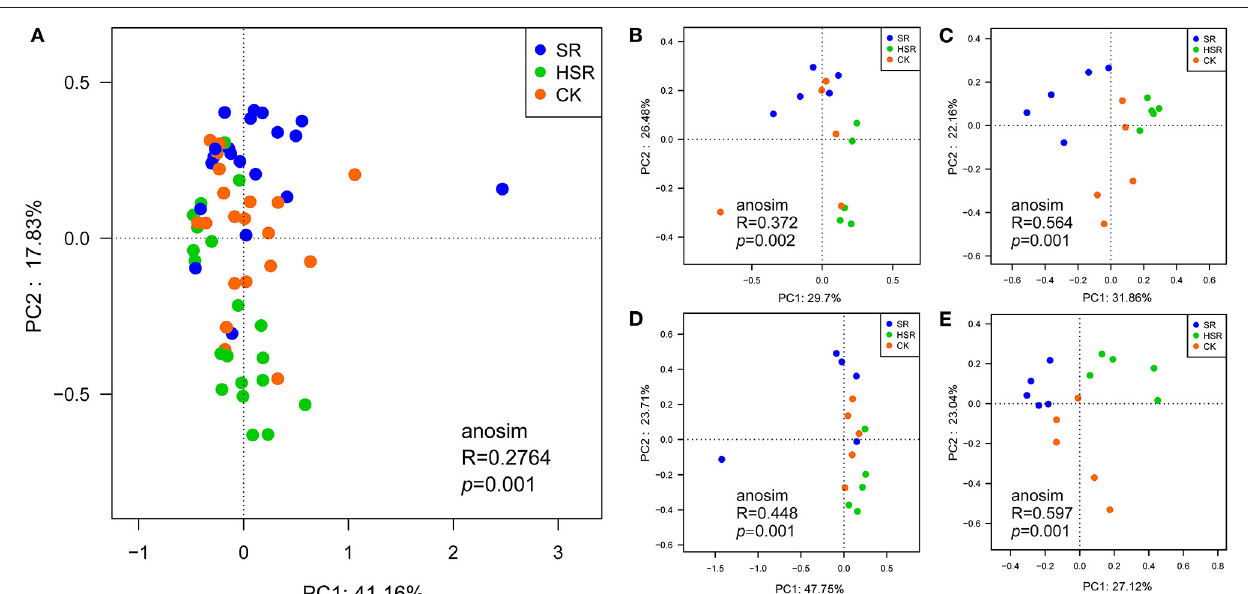
FIGURE 2 | Effect of different amounts of corn straw returned to the field on the beta diversity of soil bacteria. (A) PCoA Analysis of Bacteria Based on Bray-curtis Dissimilarity OTU Matrix. (B) PCoA analysis in the jointing stage of the wheat season. (C) PCoA analysis in the harvesting stage of the wheat season. (D) PCoA analysis in the tasseling stage of the corn season. (E) PCoA analysis in the maturity stage of the corn